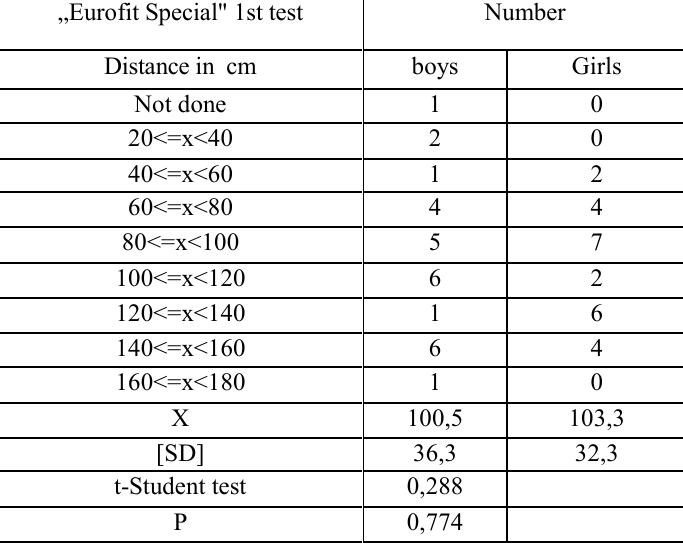
First test results. Comparison of average values between groups of boys and